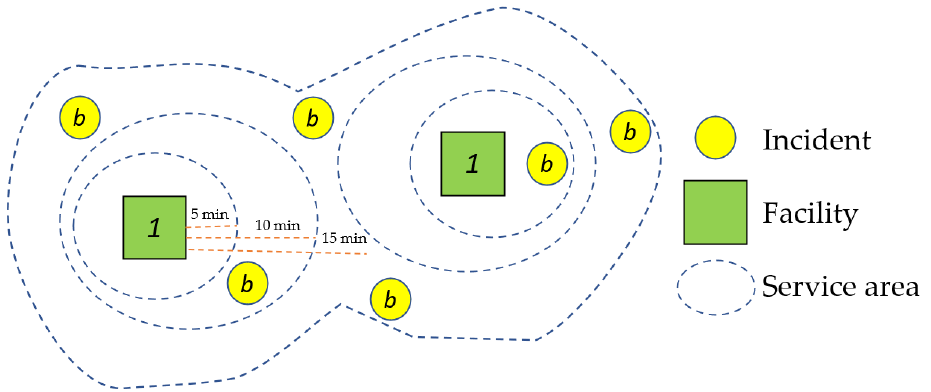
Figure 4. Illustration of service area analysis.